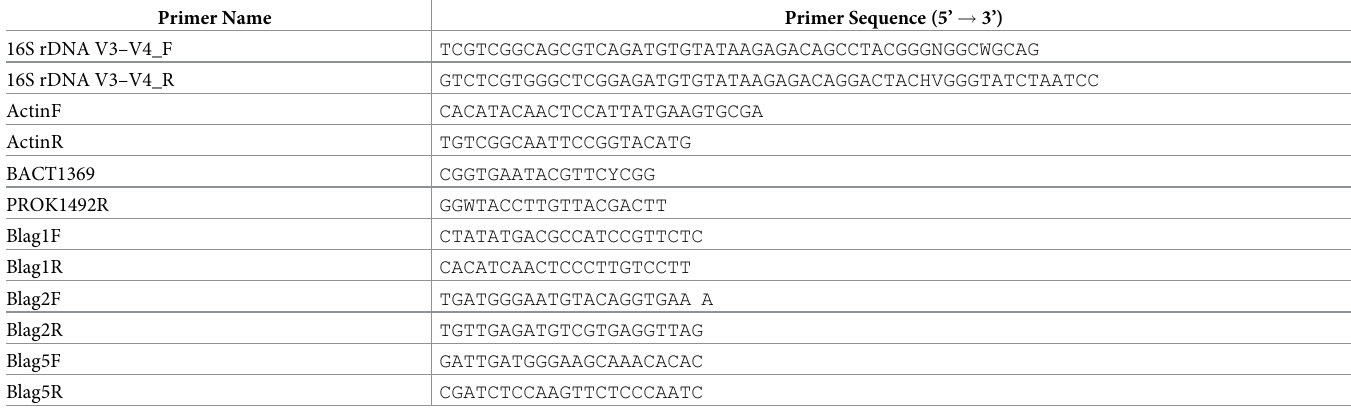
Table 1. Primers used in this